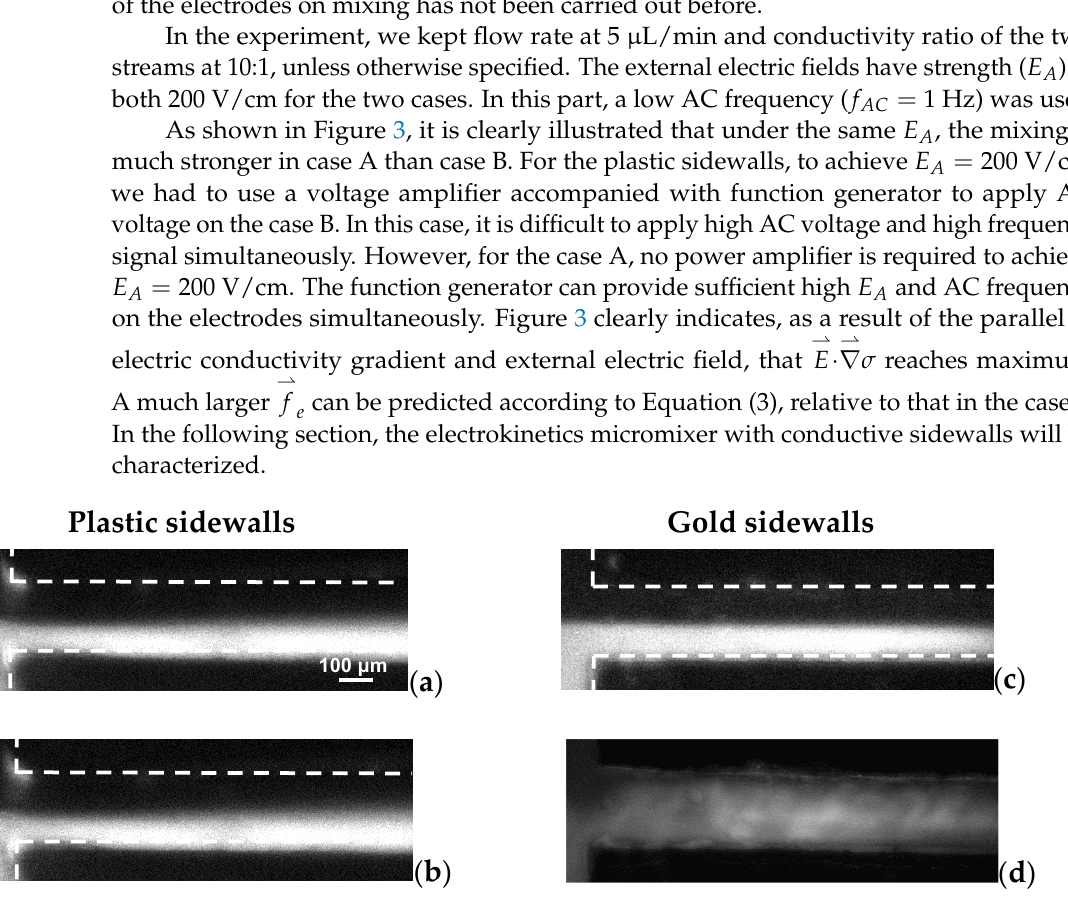
Figure 2. Experimental setup.